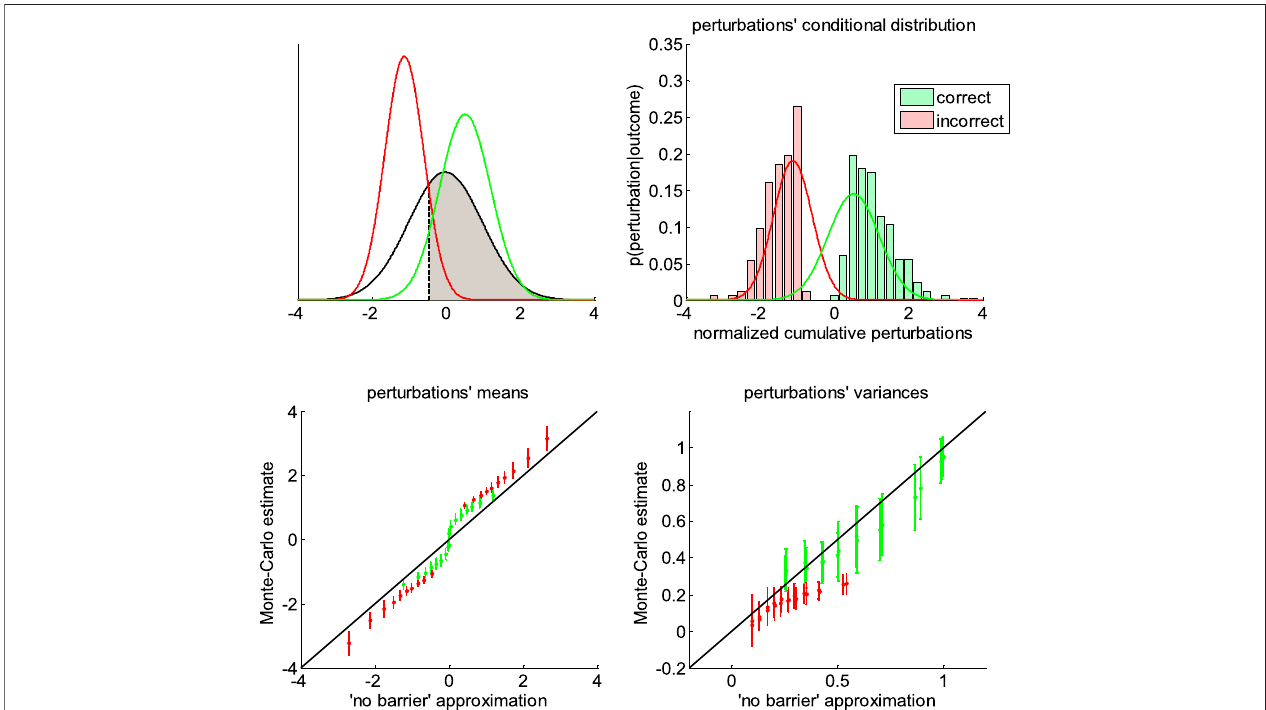
FIGURE 6 | Approximate conditional distributions of the normalized cumulative perturbations. Upper-left panel: The black line shows the “ no barrier ” standard normal distribution of normalized cumulative perturbations. The shaded gray area has size Q (cid:2) , and its left bound (dashed black line) is the critical value ~ η (cid:2) below which cumulative perturbationseventually induce errors. The green and red lines depict theensuingapproximate conditional distributions given in Eq. 13 . Upper-right panel: a Representative monte-carlo simulation. The green and red bars show the sample histogram of normalized cumulative perturbations for correct and erroneous decisions, respectively (over 200 trials, same simulation as in Figure 5 ). The green and red lines depict the corresponding approximate conditional normal distributions (cf. Eq.13 ).Lower-leftpanel:Thesamplemeanestimatesofconditionalperturbations( y -axis)areplottedagainsttheir “ nobarrier ” approximation( x -axis, Eq.11 ).Monte- carlo simulations are split according to the sign of the drift rate, and then binned according to deciles of approximate conditional means of normalized cumulative perturbations (green: Correct, red: error, errorbars: Within-decile means ± standard deviations). The black dotted line shows the identity mapping (perfect approximation). Lower-right panel: The sample variance estimates of normalized cumulative perturbations ( y -axis) are plotted against their “ no barrier ” approximation ( x -axis, Eq. 12 ). Same format as lower-left